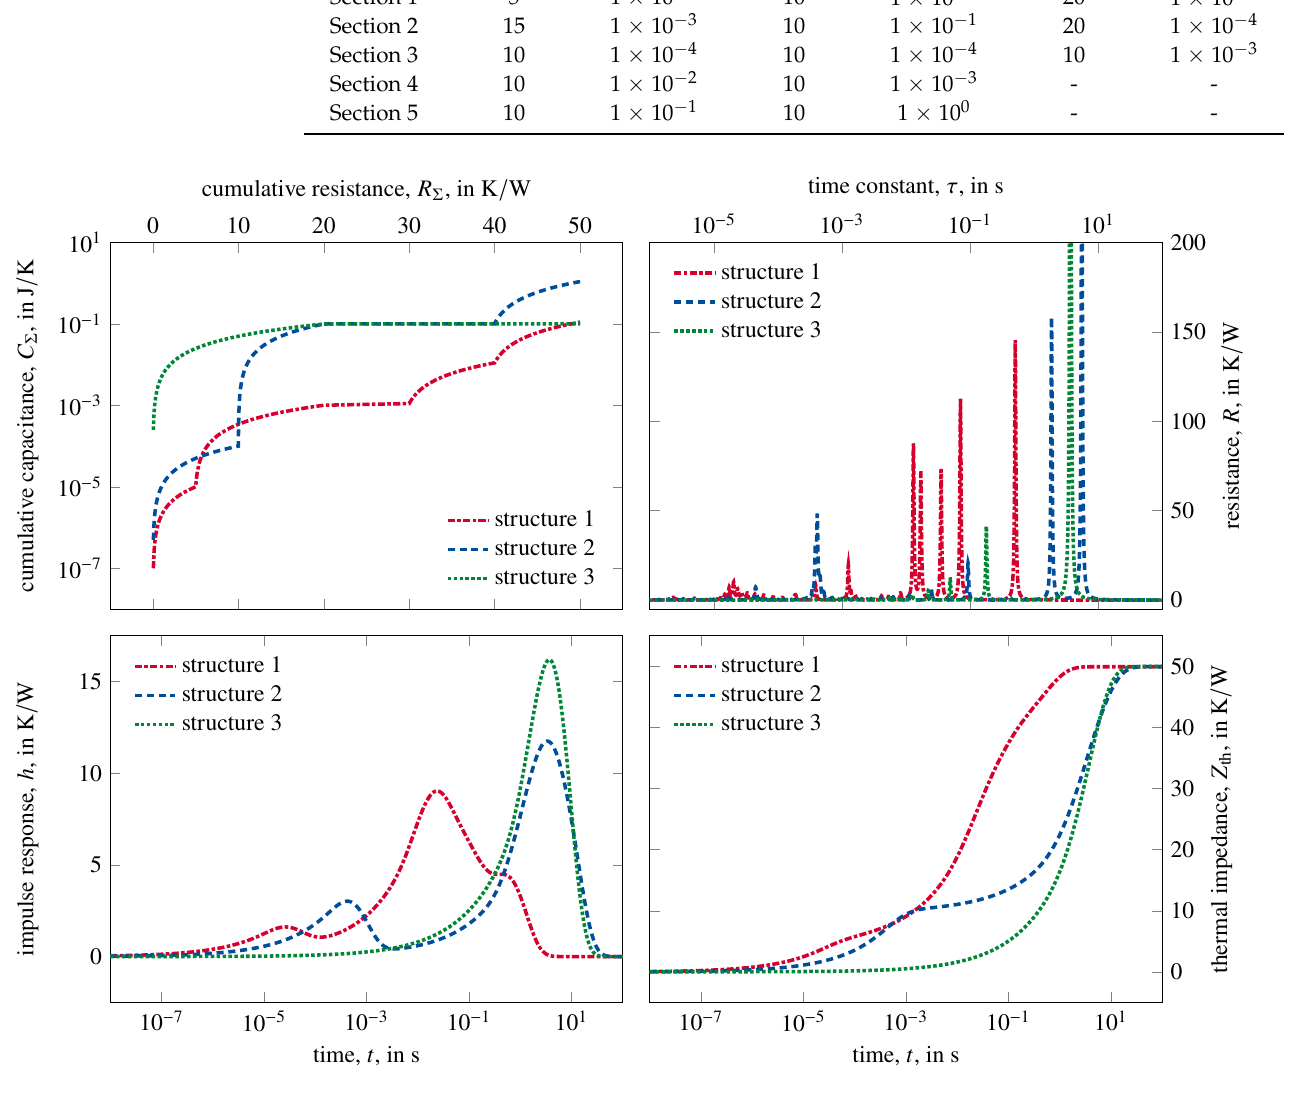
Figure 3. Overview on the three test structure functions ( top left ), their corresponding time constant spectra ( top right ), impulse responses ( bottom left ), and thermal impedances ( bottom right ), calculated at δ = 0.03°. For presentability, the time constant spectra plotted are calculated with δ =